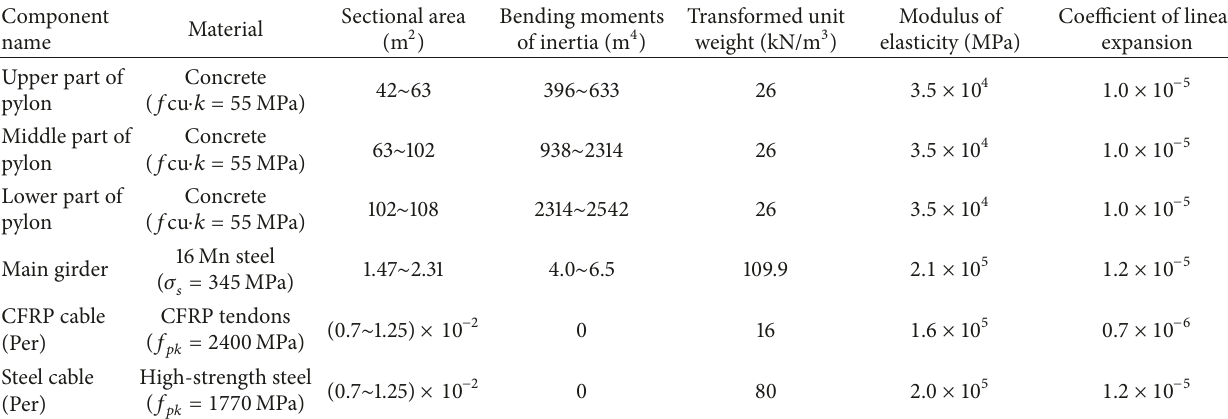
Table 1: Parameters of main components.